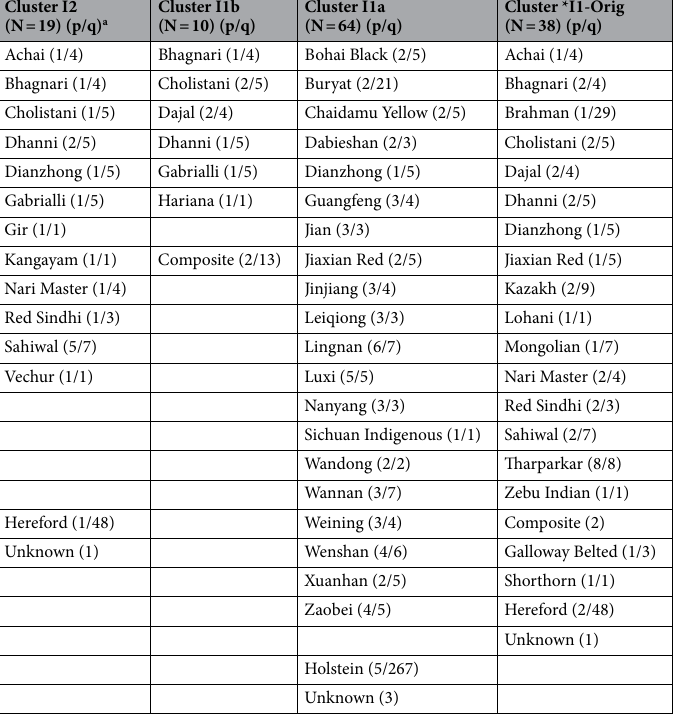
Table 6. Breed annotation and the number of animals within subclusters of the indicus (I) cluster based on alternate clustering techniques. a N = total number of animals in the cluster, p = No. of animals within breed in the haplogroup, q = total No. of animals within the breed, *I1-Orig = remaining animals under I1 haplogroup after assignment of other animals to I1a and